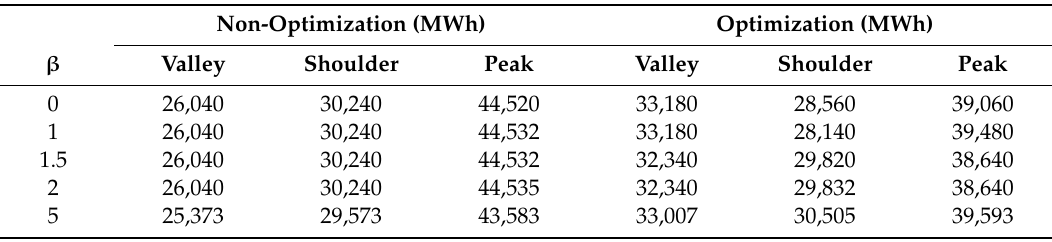
Table 10. Total procurement on valley, shoulder and peak hours for di ff erent risk aversion factors with and without starting-time optimization.